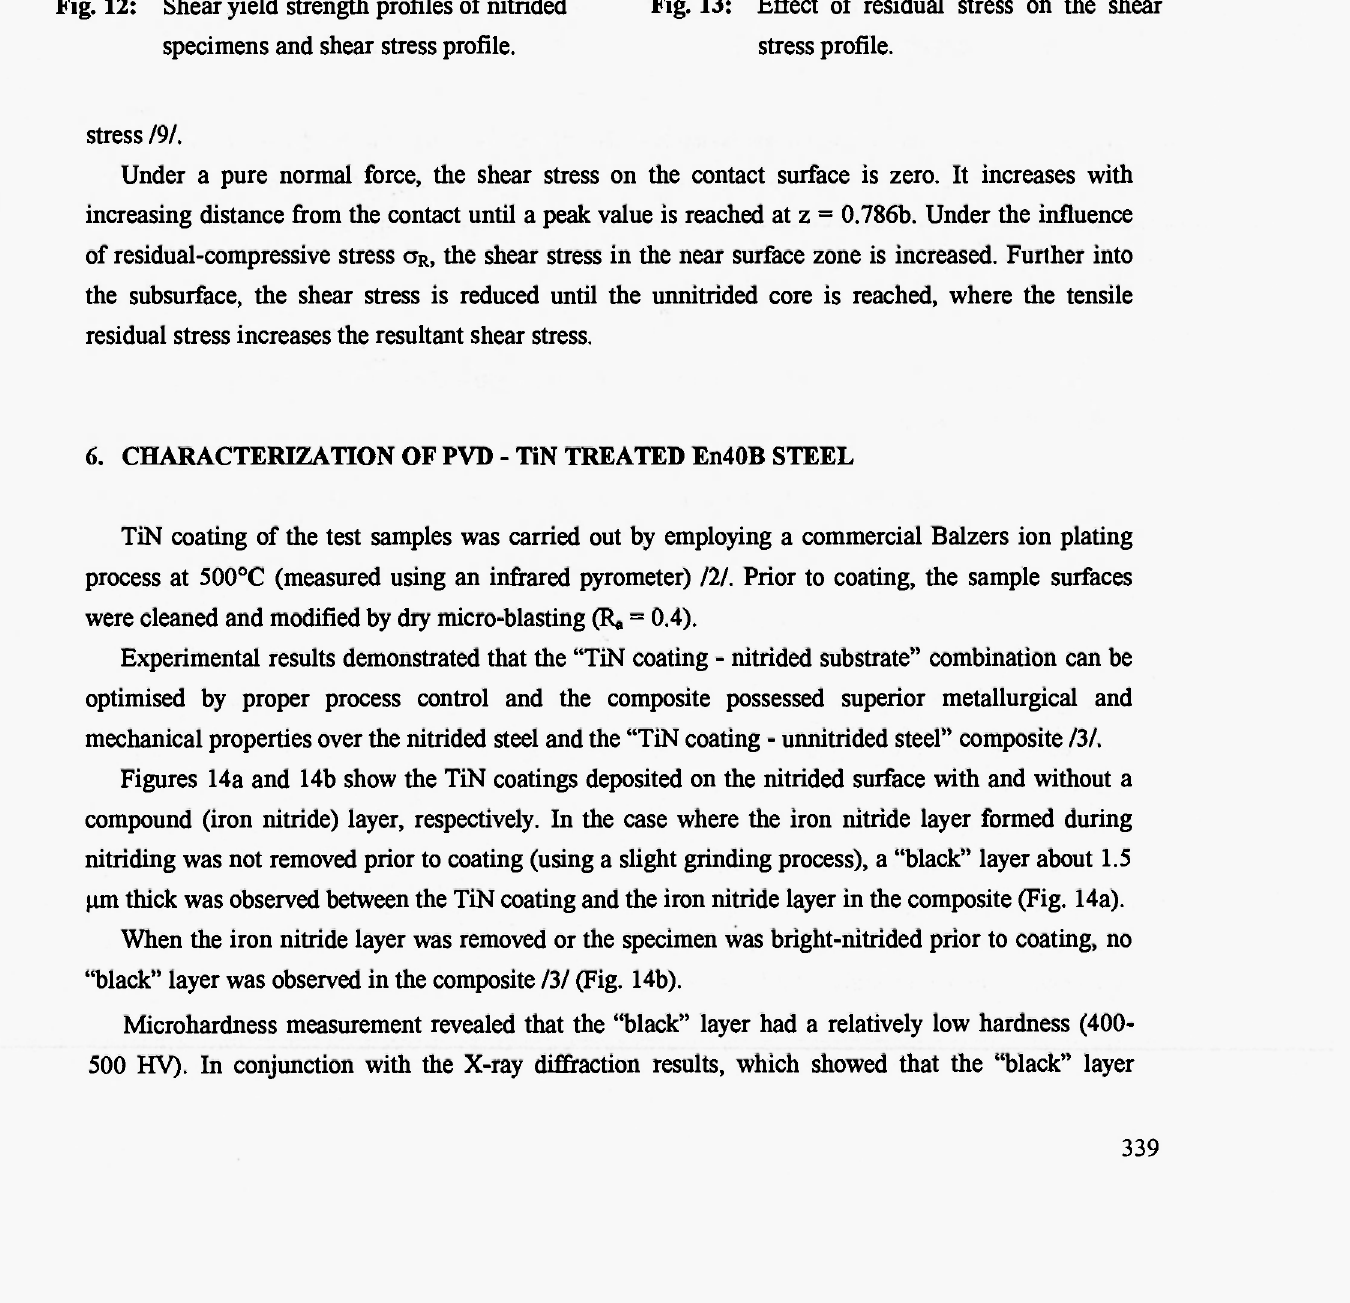
11.(1 III 0.2 0.1 I WITH 1-KOM SUKI Λ(Ί·. mm Fig. 12: Shear yield strength profiles of nitrided specimens and shear stress profile.